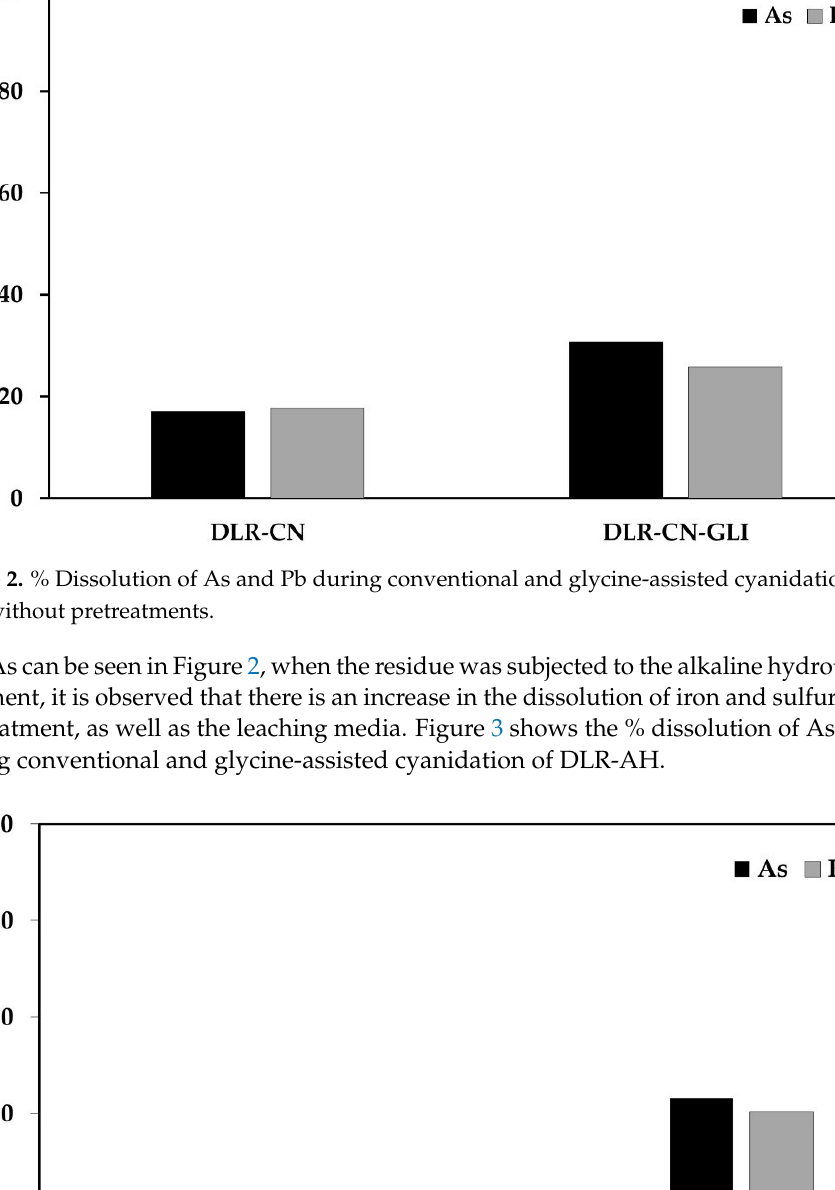
Figure 3. % Dissolution of As and Pb during conventional and glycine-assisted cyanidation of DLR- AH.